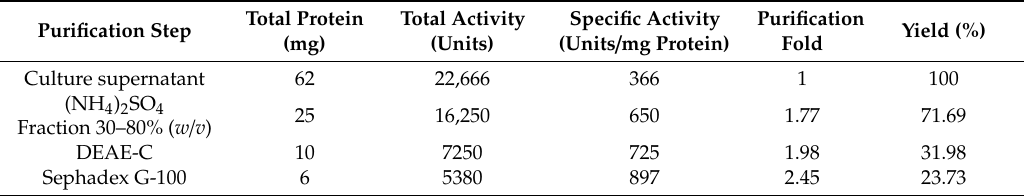
Figure 1. Screening of active protease release from B. megaterium -TK1 using skim milk agar plates. After 2 days of incubation, a clear transparent hydrolytic zone appeared against the white background when the plate was incubated with 10 mL of HgCl 2 reagent (HgCl 2 in 2 M HCl). Table 1. Overview of B. megaterium -TK1-derived protease purification steps and